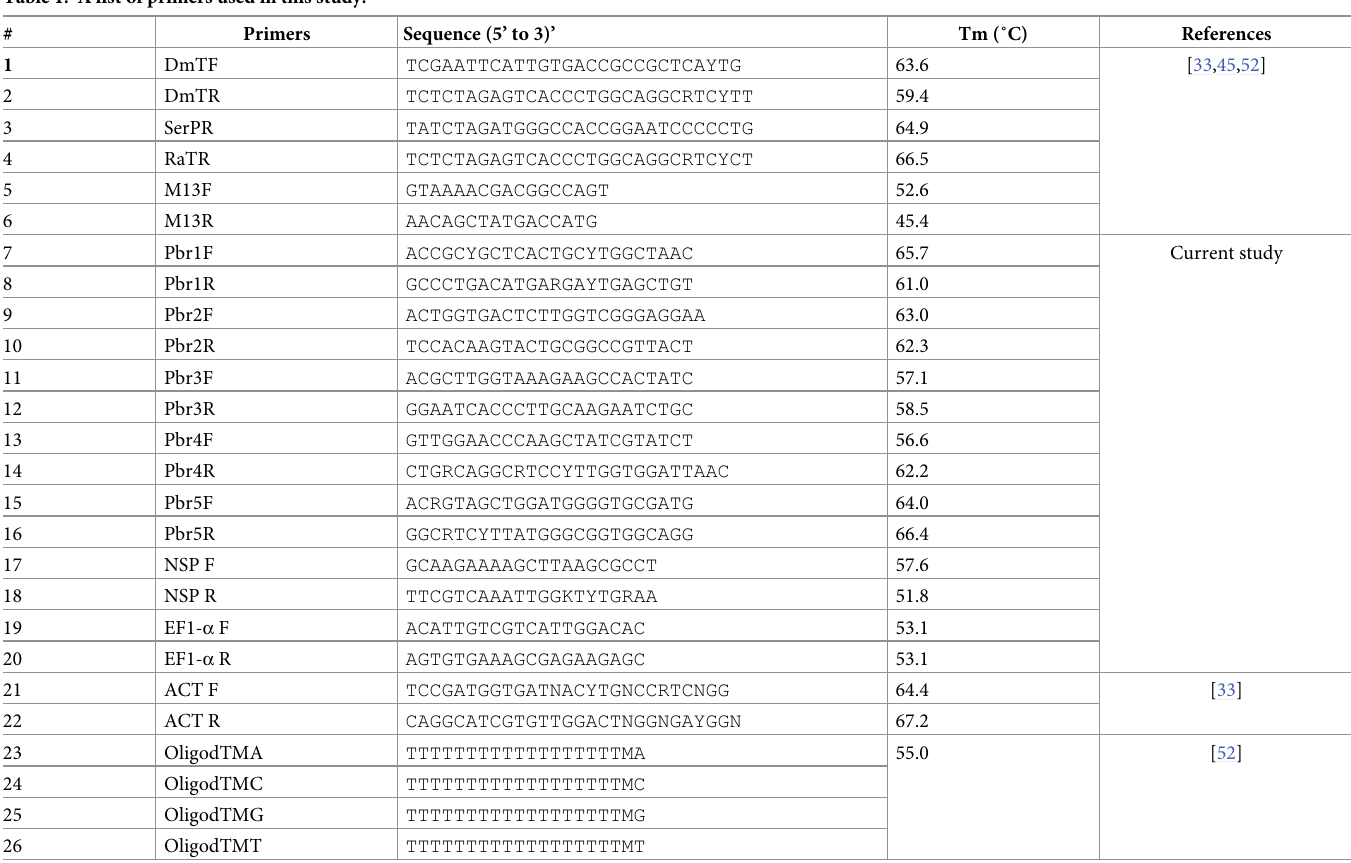
Table 1. A list of primers used in this study.